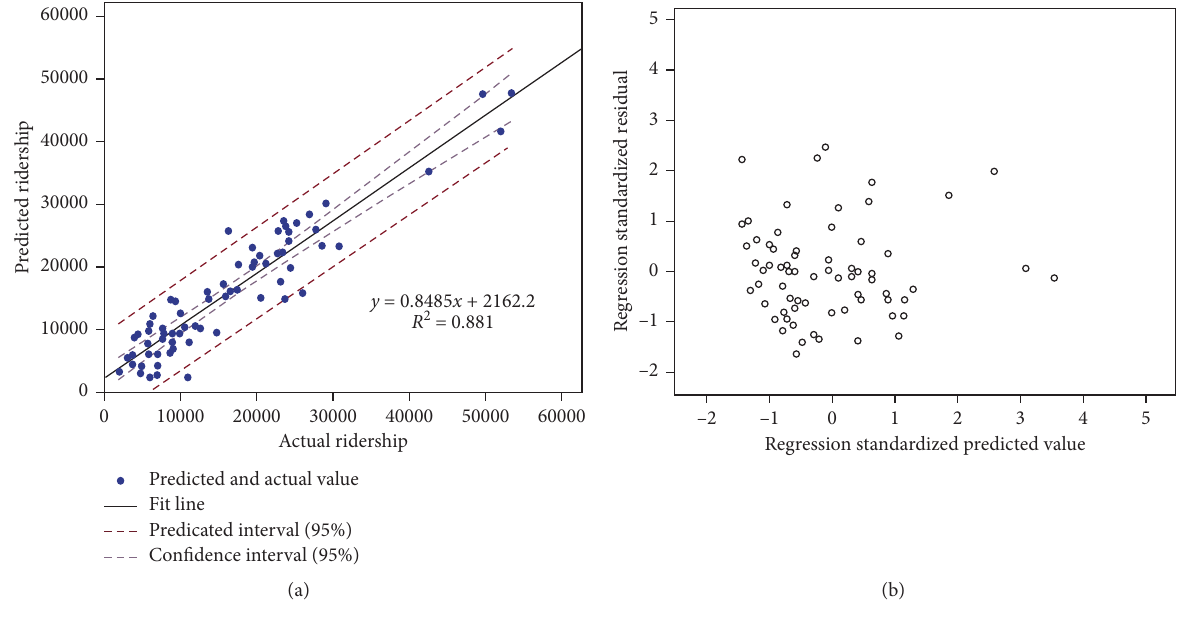
Figure 5: Predicted versus actual ridership (a) and residual analysis